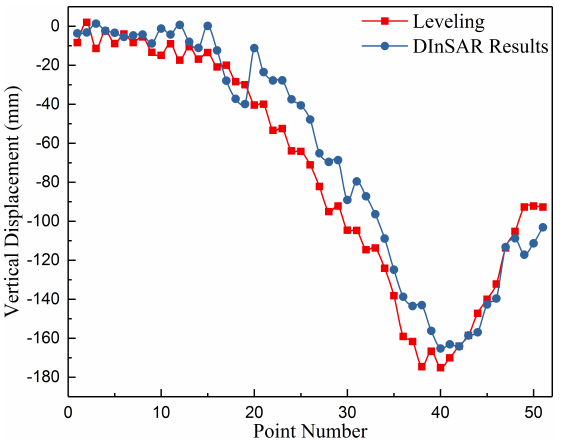
Figure 13. Comparison of the subsidence curves. Leveling points are arranged from northeast to southwest and from small to large in the strike